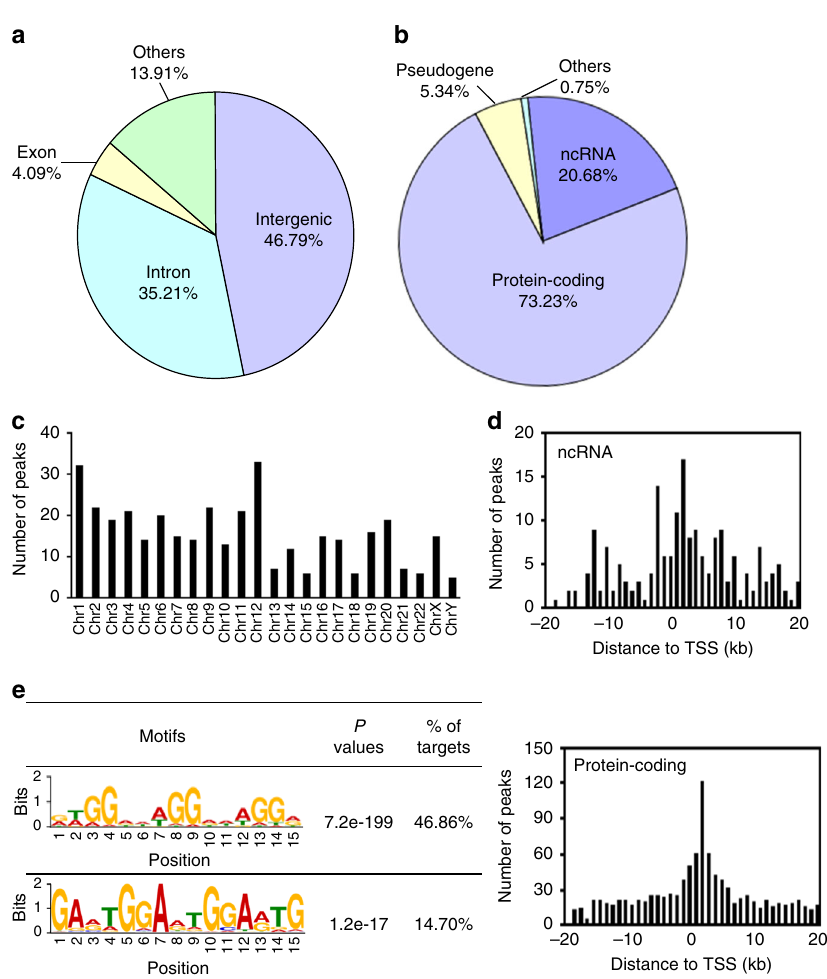
Fig. 2 Genome-wide analysis of potential PtpA-binding sites in U937 cells. a Genomic distribution of potential PtpA-binding regions in U937 cells. b Biotype distribution of potential PtpA-binding regions in U937 cells. c Distribution of the chromosomal location of PtpA-speci fi c ChIP-seq signals (fold-enrichment > 10). d The number and position of the potential PtpA-binding sites along 20 kb from the nearest TSS of the ncRNAs or protein-coding genes, respectively. e PtpA consensus motifs de fi ned by MEME motif analysis of the sequences of PtpA ChIP-seq peaks. P values were calculated by TOMTOM match statistics. “ % of targets ” represents the percentage of motif-containing fractions in potential PtpA targets. The size of each letter was proportional to the frequency of each nucleotide in that position within the consensus